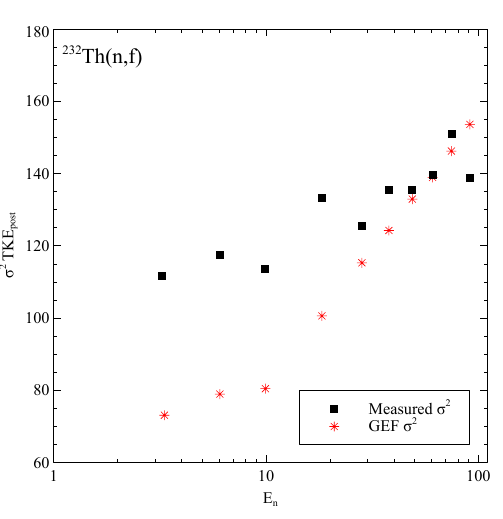
Figure 6. Measured and GEF calculated variances of the TKE distributions for the fast neutron induced fission of 237